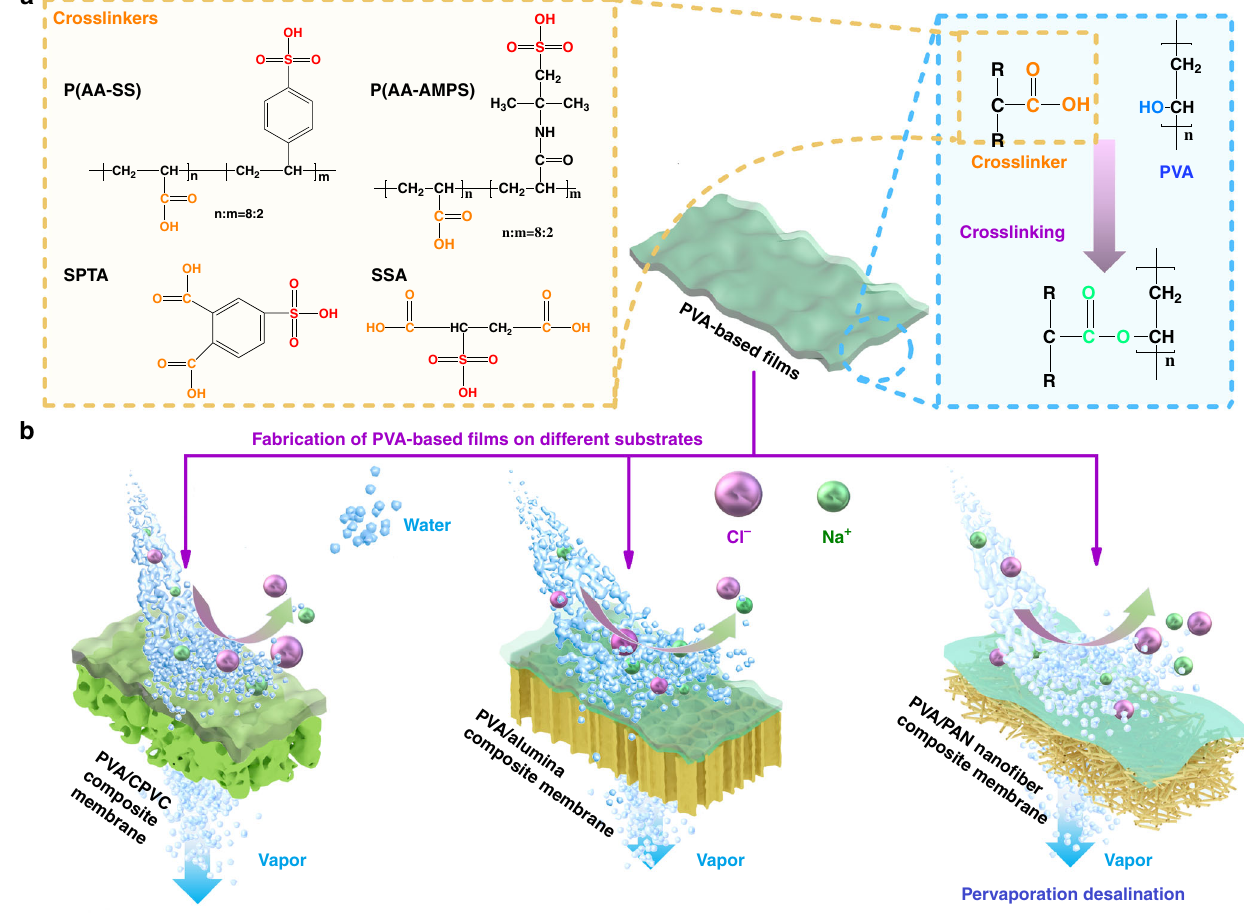
Fig. 1 Structures of the crosslinkers and composite PV membranes. a The molecular structures of crosslinkers and the reaction scheme for crosslinking PVA fi lms. b The diagrams of water transport from a NaCl feed solution through the PVA-based TFC membranes using porous substrates, including CPVC ultra fi ltration membrane, alumina disc, and PAN nano fi ber